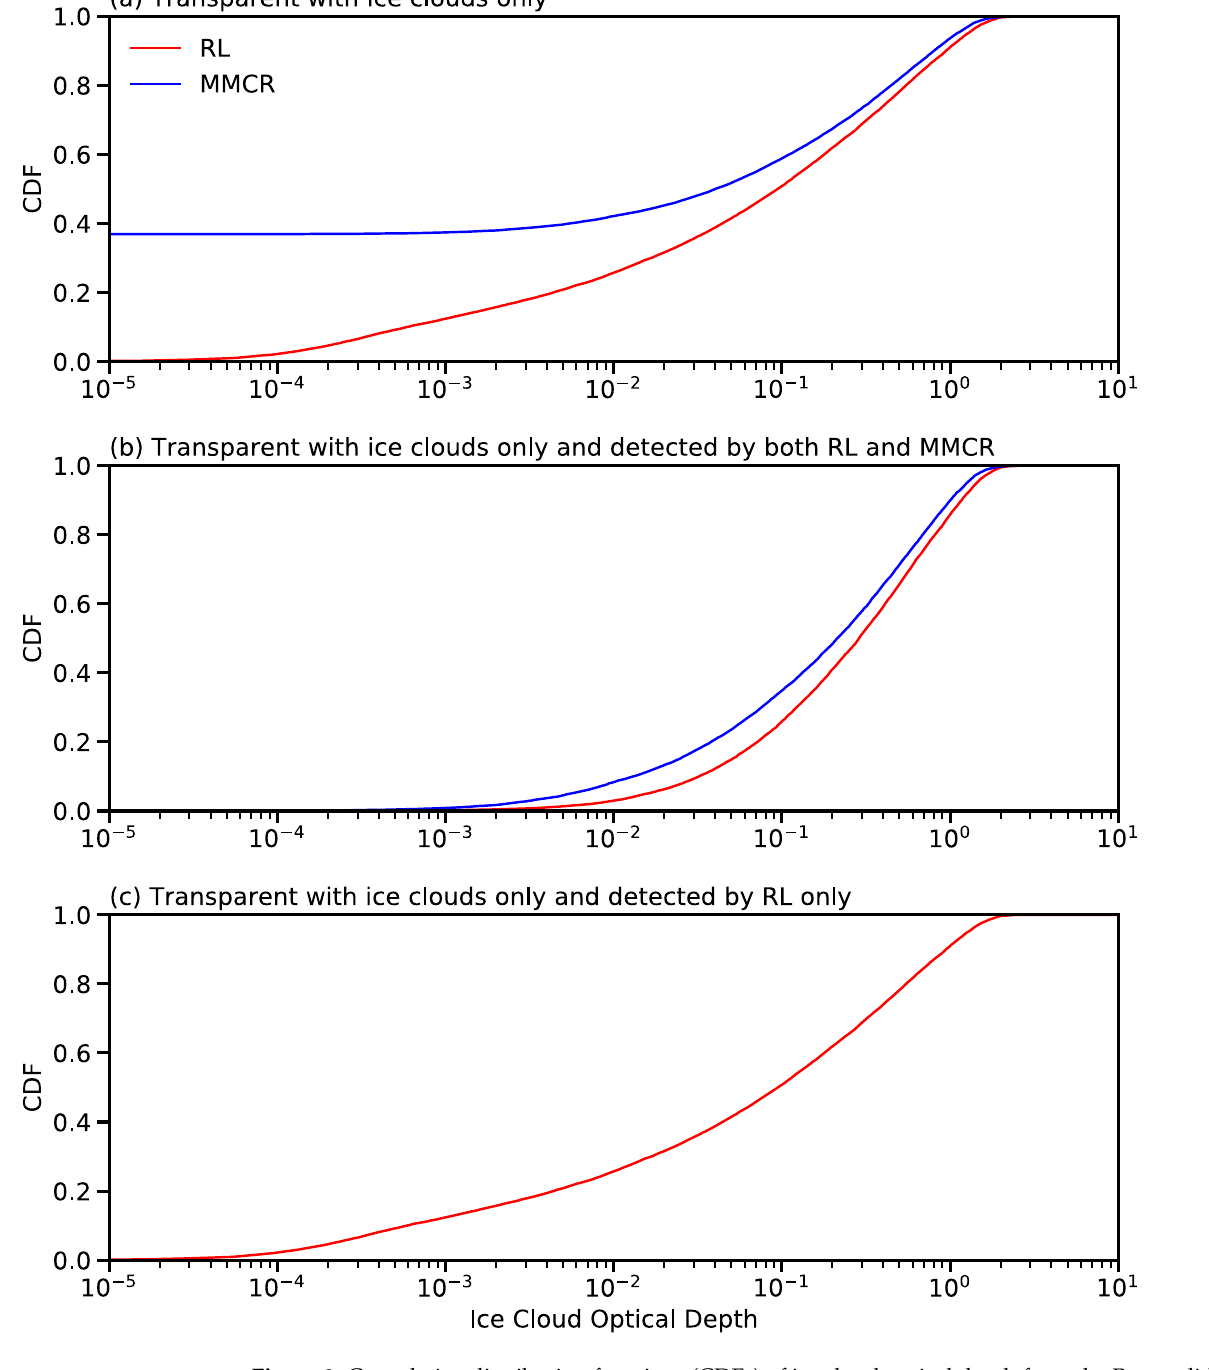
Figure 3. Cumulative distribution functions (CDFs) of ice cloud optical depth from the Raman lidar (RL; red) and millimeter wavelength cloud radar (MMCR; blue) observations at the Southern Great Plains (SGP) site from August 2008 to January 2011. The observations are shown for profiles that are ( a ) transparent with ice clouds only, ( b ) transparent with ice clouds only and detected by both RL and MMCR, and ( c ) transparent with ice clouds only and detected by RL only. In ( c ), no ice clouds are detected by MMCR, and thus only the RL result is shown here.